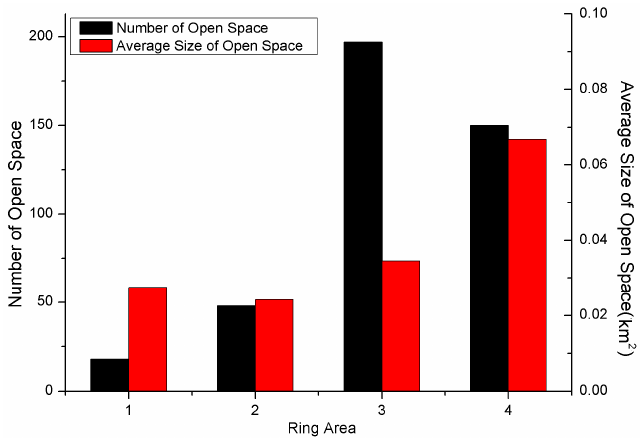
Figure 4. Number and size of open space in each ring area.